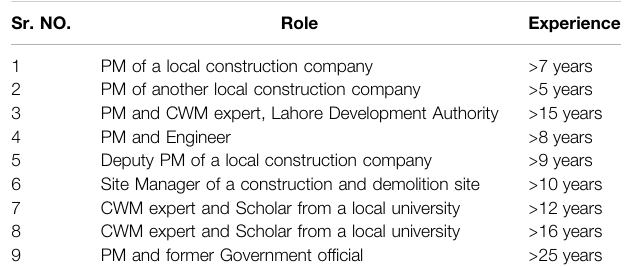
TABLE 1 | Pro fi les of the respondents.